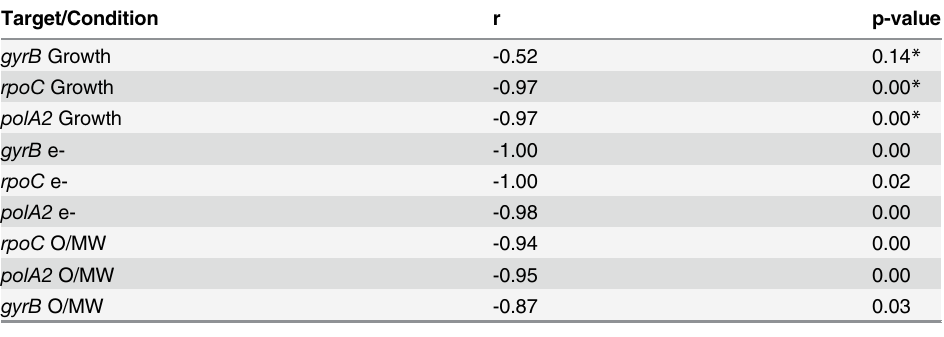
Table 7. Pearson Product Correlation values obtained for ratio and C T of gyrB , polA2 , and rpoC under each